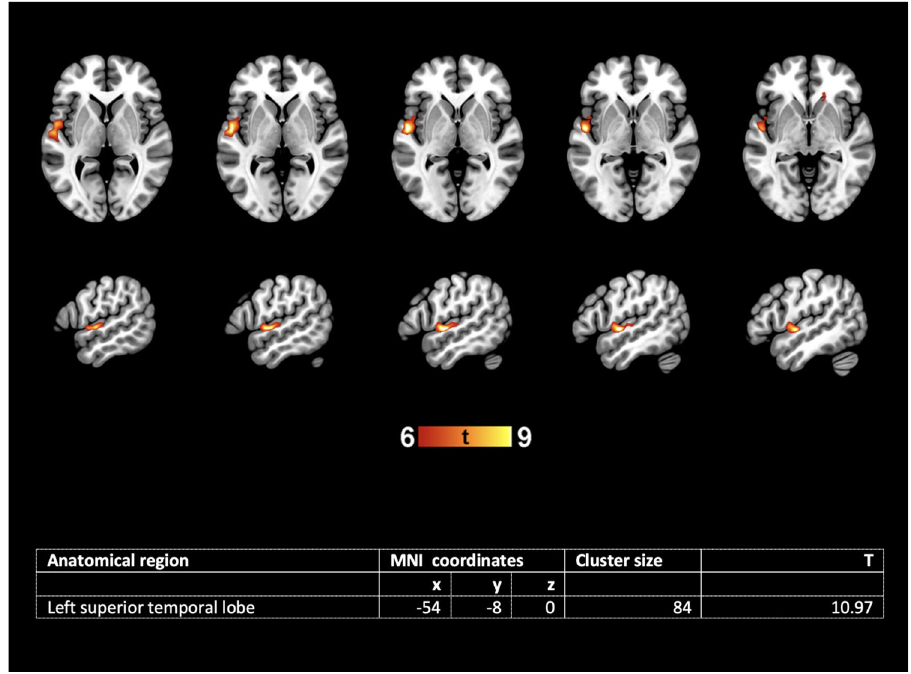
Fig. 2 LIs of fetal STS depths predict later language activation within the left superior temporal lobe (second level multiple linear regression analysis, adjusted for age at test and MR device; n = 23, p < 0.05, FWE-corrected). Coordinates are given of the peak voxel in the activated cluster. Activation is depicted on a normalized T1 template, neurological